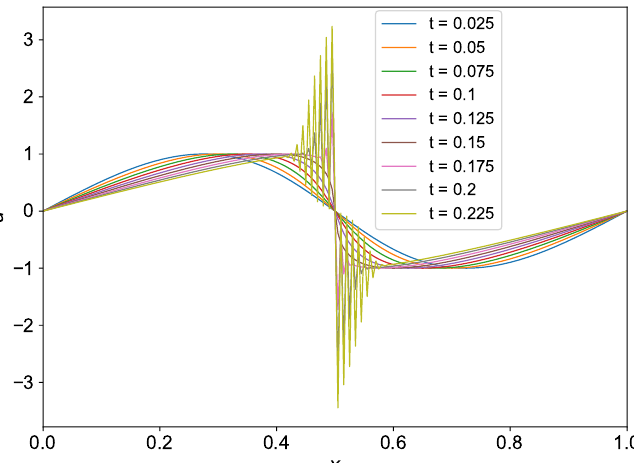
Figure 6. Evolution of shock with time for the initial condition u 0 = sin ( 2 π x ) using FTCS